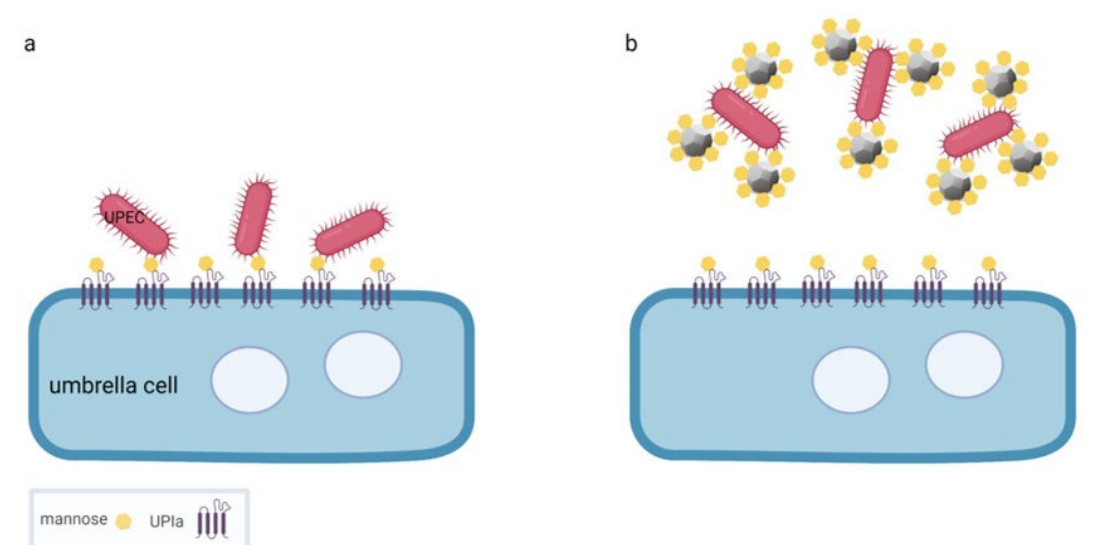
Figure 4. Possible mechanism to prevent UPEC from attaching to urothelial cells. ( a ) The apical plasma membrane of the umbrella cell has transmembrane proteins uroplakin Ia (UPIa) with four transmembrane domains and mannose units to which UPEC attach before entering the cell. ( b ) NDs conjugated with mannose units could bind to UPEC, occupying the binding sites and thus preventing their attachment to umbrella cells. The illustration was created by the authors using the BioRender app.